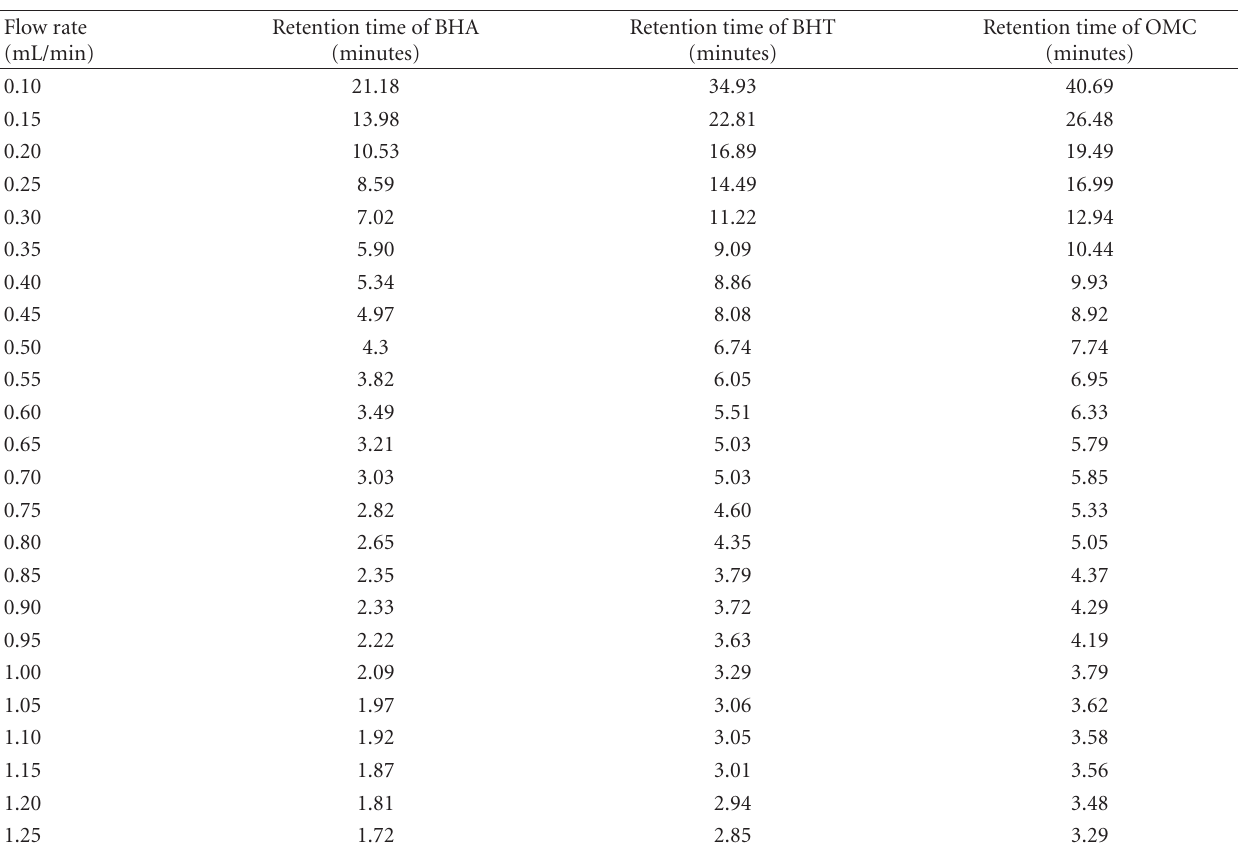
Table 2: The retention times of BHA, BHT, and OMC at di ff erent flow rate of mobile phase.